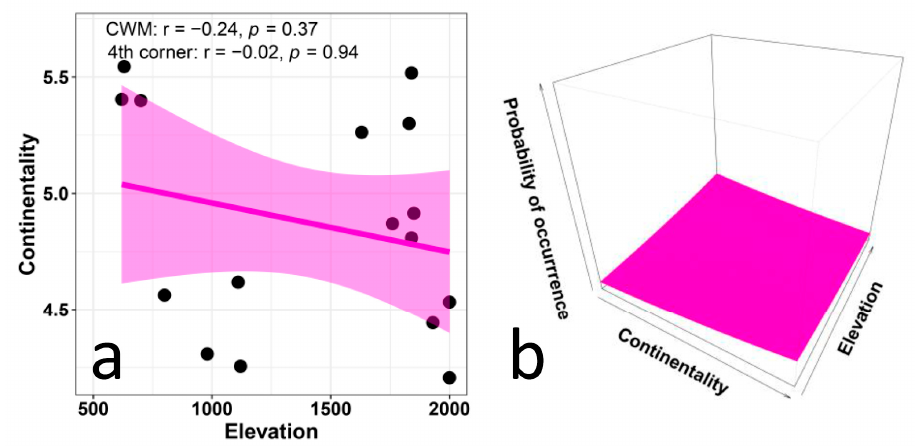
Figure 5. Relationship between Ellenberg indicator values for continentality and elevation in plant com- munities along an elevational gradient in Central Italy. The left panel ( a ) presents the CWM regression model and statistical corrections based on the fourth-corner analysis. The right panel ( b ) presents the results of the multi-level model (trait × environment interaction p < 0.001, marginal R 2 =